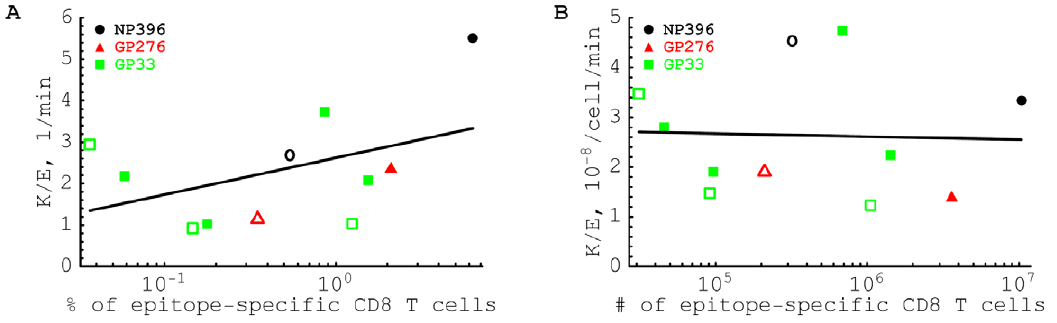
Figure 4. The estimated per capita killing efficacy of CD8 + T cells is independent of the average percent (panel A) or average number of epitope-specific CD8 + T cells in the spleen. We estimate the killing efficacy k by dividing the death rate of targets K by the frequency (panel A) or the number (panel B) of epitope-specific CD8 T cells in the spleen E . Notations are the same as in Fig. 3. Lines show linear regression for the estimates of the killing efficacy and log transformed frequency (panel A) or number (panel B) of epitope-specific CD8 z T cells. Slopes for the regressions are not statistically different from zero (panel A: slope=0.89, p ~ 0 : 19 ; panel B: slope= 2 0.06, p ~ 0 : 91 ). A large positive slope for the correlation between per capita killing k and the frequency of epitope-specific CD8 z T cells in panel A is due to an outlier for killing by NP396-specific effector CD8 z T cells. Removing this outlier led to the estimated slope=0.06, p ~ 0 : 90 . The average killing efficacy of CD8 z T cells is 2 : 33 min { 1 (panel A) or 2 : 62 | 10 { 8 cell { 1 min { 1 (panel